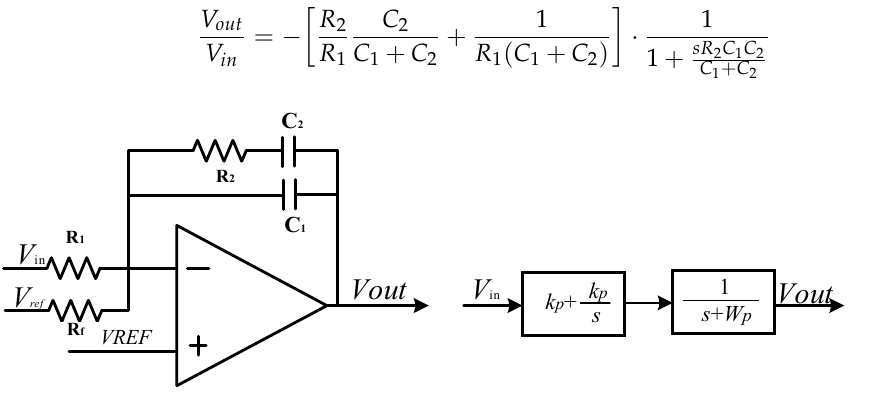
Figure 11. Schematic diagram of the AGC module of the driving circuit.